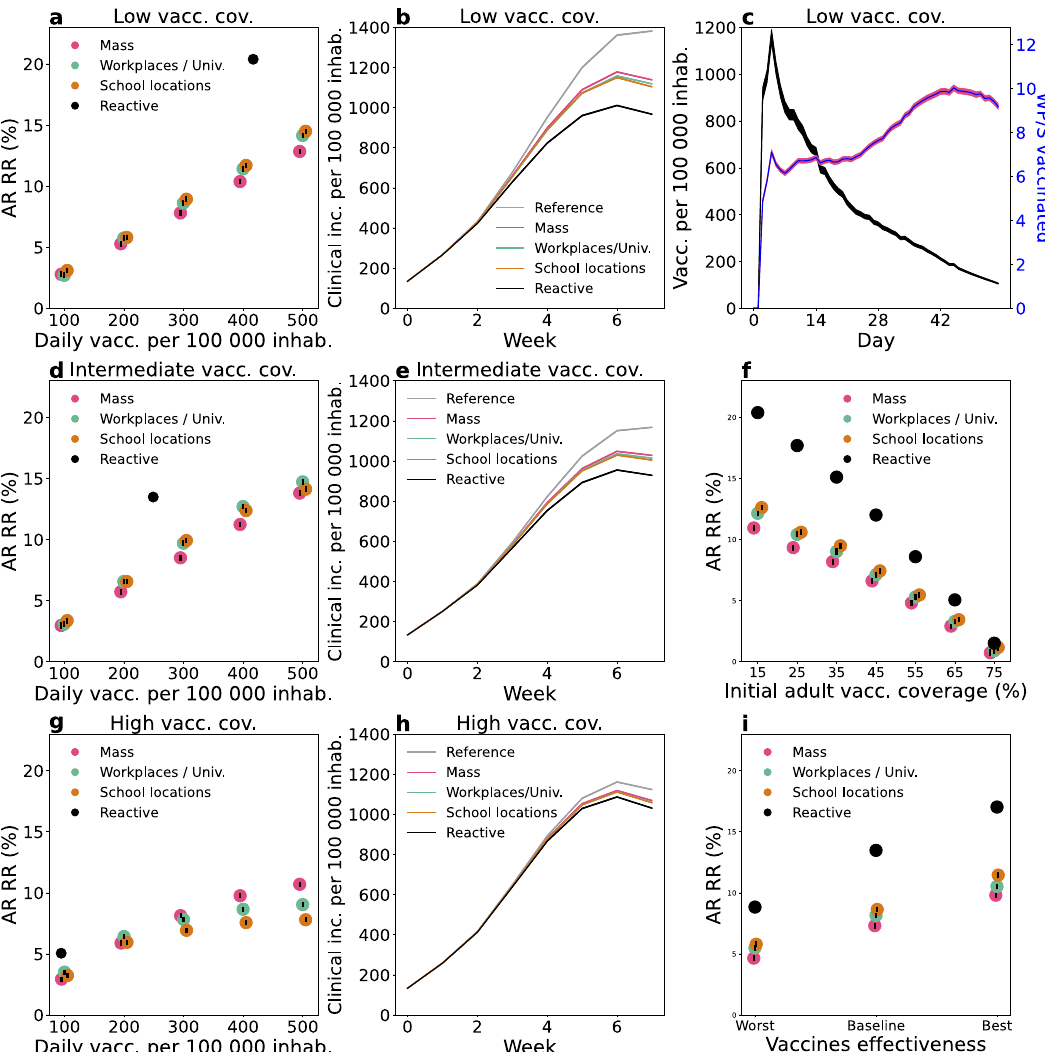
Fig. 2 Comparison between vaccination strategies. a – h Comparison between reactive and non-reactive vaccination strategies for the baseline scenario and different values of initial vaccination coverage. a , d , g Relative reduction (RR) in the attack rate (AR) over the fi rst 2 months for all strategies as a function of the vaccination pace. RR is computed as (AR ref − AR)/AR ref with AR ref being the AR of the reference scenario, where no vaccination campaign is conducted during the course of the simulation and vaccination coverage remains at its initial level. AR is computed from clinical cases. Three initial vaccination coverages are investigated: 15% of adults (low) ( a ); 40% of adults (intermediate) ( d ) and 65% of adults (high) ( g ). b , e , h Weekly incidence of clinical cases for 100,000 inhabitants for the fi rst 8 weeks with different vaccination strategies. The non-reactive scenarios plotted are obtained with the same average daily vaccination pace as for reactive vaccination. Low, intermediate and high vaccination coverages are investigated in b , e , h , respectively. c Number of daily fi rst-dose vaccinations, and number of workplaces/schools (WP/S in the plot) where vaccines are deployed for the same reactive scenario as in a , b — low vacc. cov., with 15% initial vaccine coverage. f AR RR for different initial vaccination coverages. The four strategies are compared at equal numbers of vaccine doses. The baseline epidemic scenario of panels a – h is de fi ned by the following key parameters: R = 1.6; VE S ,1 = 48%, VE SP ,1 = 53%, VE S ,2 = 70%, VE SP ,2 = 73%; initial immunity 32%; initial incidence 160 clinical cases weekly per 100,000 inhabitants; 90% of 60 + vaccinated at the beginning. i AR RR for different vaccine effectiveness levels, assuming intermediate vaccination coverage (40% of adults) and all other parameters as in panels a – h . The baseline vaccine effectiveness values used in the other panels is compared with a worst and a best-case scenario, de fi ned respectively by VE S ,1 = 30%, VE SP ,1 = 35%, VE S ,2 = 53%, VE SP ,2 = 60%, and by VE S = 65%, VE SP = 75%, VE S = 80%, VE SP = 95%. For each vaccine effectiveness scenario the four strategies are compared at equal numbers of vaccine ,1 ,1 ,2 ,2 doses. In panels a , d , f , g , i , data are means over 2000 independent stochastic realisations and error bars are derived from the standard error of the mean — these are smaller than the size of the dot in the majority of cases. In panels b , c , e , h , continuous lines are means over 2000 independent stochastic realisations and the shaded areas are the standard error of the mean (±2SEM) — not visible in panels b , e , h . The distribution of outcomes over all 2000 independent stochastic realisations is provided in Supplementary Fig. 3 comparing all vaccination strategies and considering the parameterisation of Fig. 2e as an example. The following abbreviations were used in the Fig.: vacc. for vaccines, inhab. for inhabitants, cov. for coverage, inc. for incidence, univ. for